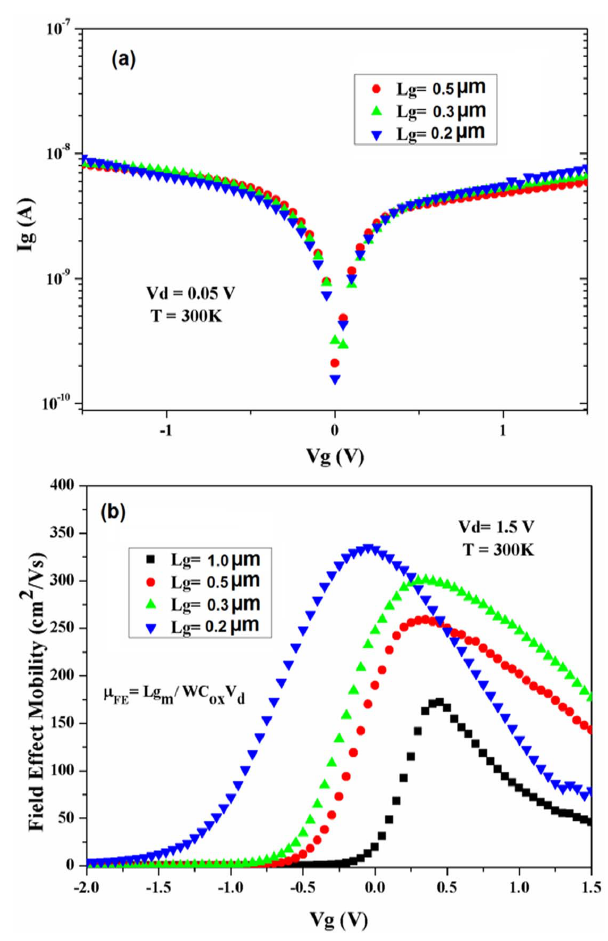
Figure 8. Gate current (a) and field effect mobility (b) versus V g for different L g for self-aligned In 0.53 Ga 0.47 As MOSFETs.